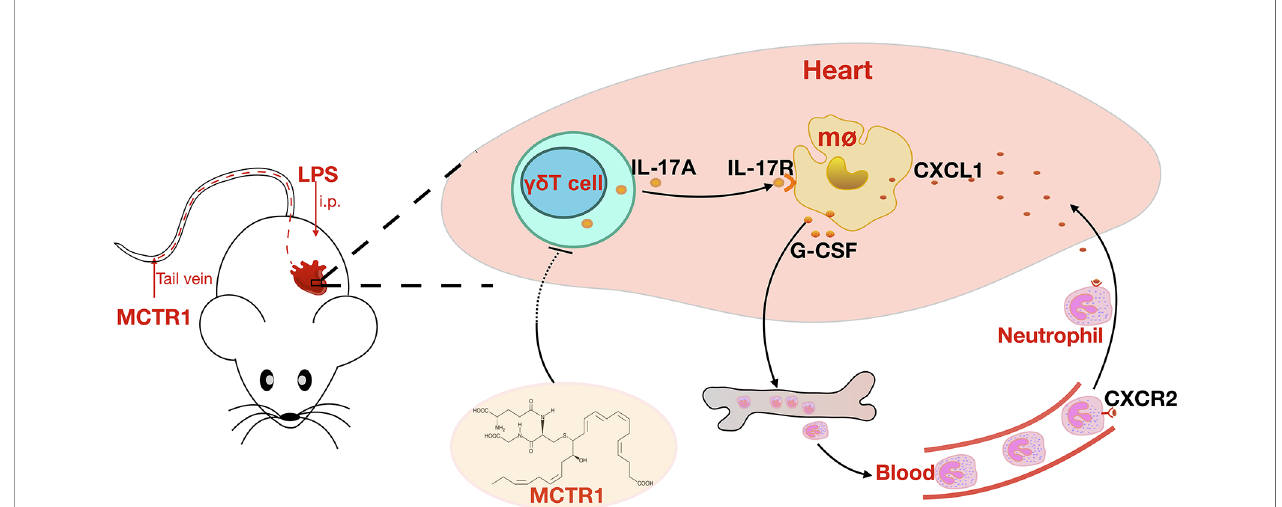
FIGURE 7 | MCTR1 reduces neutrophil in fi ltration through attenuating IL-17A production derived from gd T cells in LPS-induced cardiac